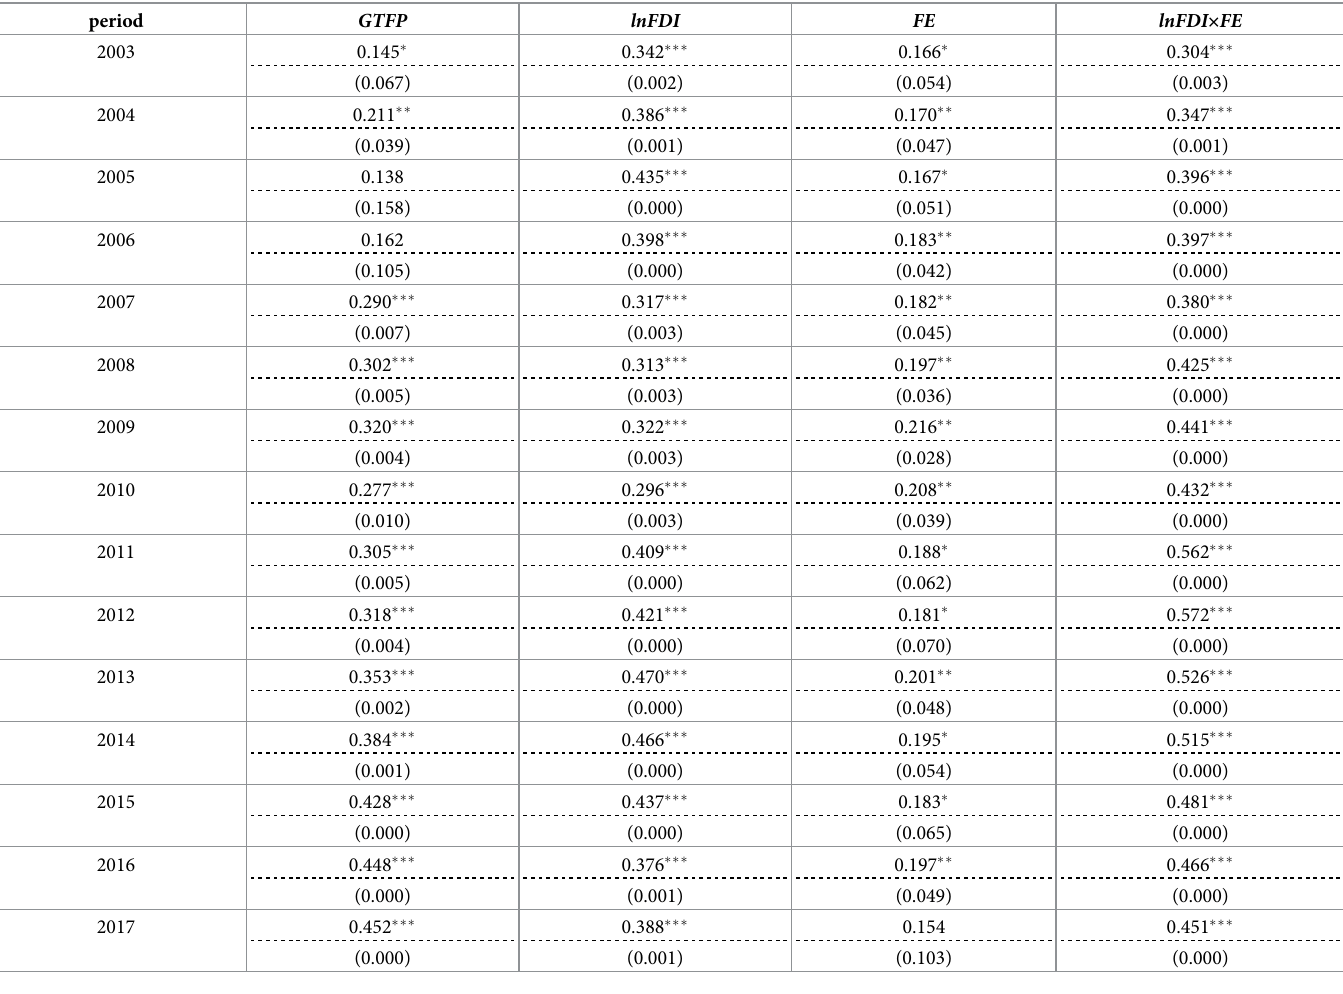
Table 5. The Moran’s I indexes of GTFP , lnFDI , FE and lnFDI × FE.